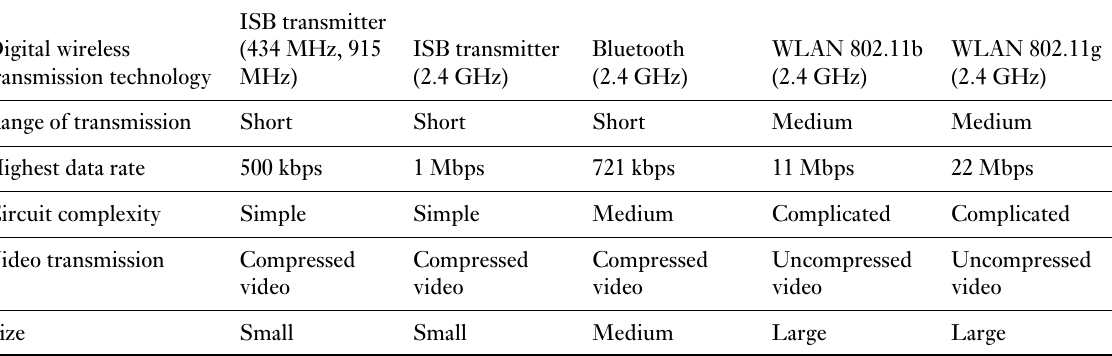
Table 2 Comparison of digital transmitters using different technologies a